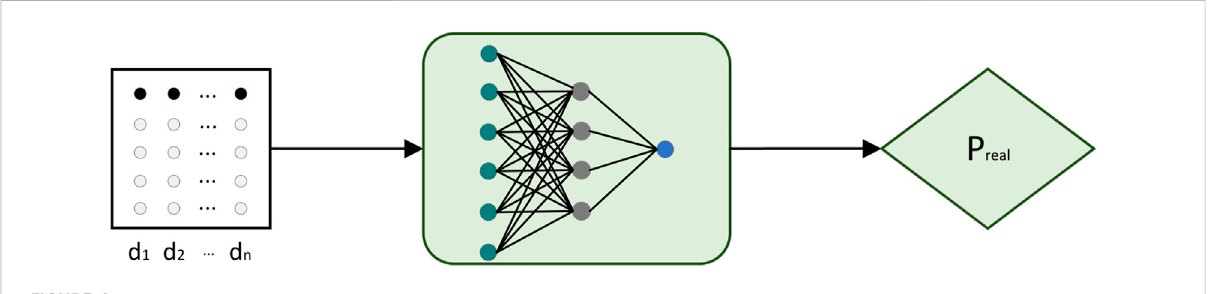
FIGURE 4 Discriminator